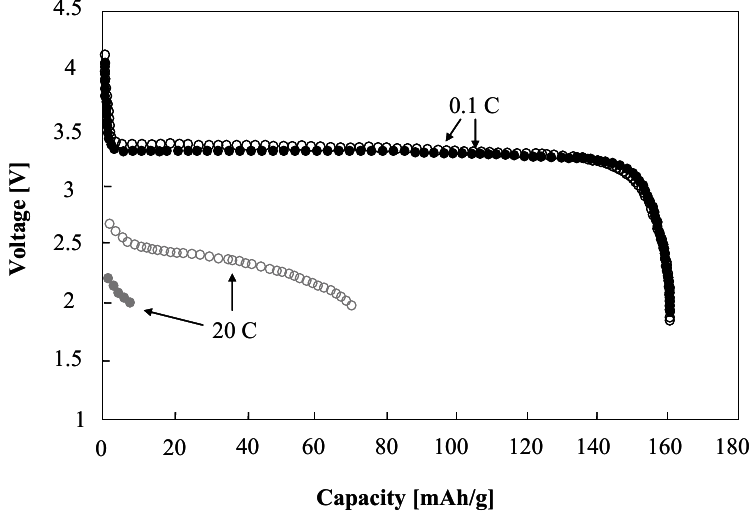
Fig. 4 Rate behaviors of prepared C/LiFePO 4 positive electrodes. Open symbol: electrode with PAA (C/LiFePO 4 : carbon black : CMC : WSB : PAA = 90 : 5 : 0.6 : 4 : 0.4), closed symbol: electrode without PAA (C/LiFePO 4 : carbon black : CMC : WSB = 90 : 5 : 1 :